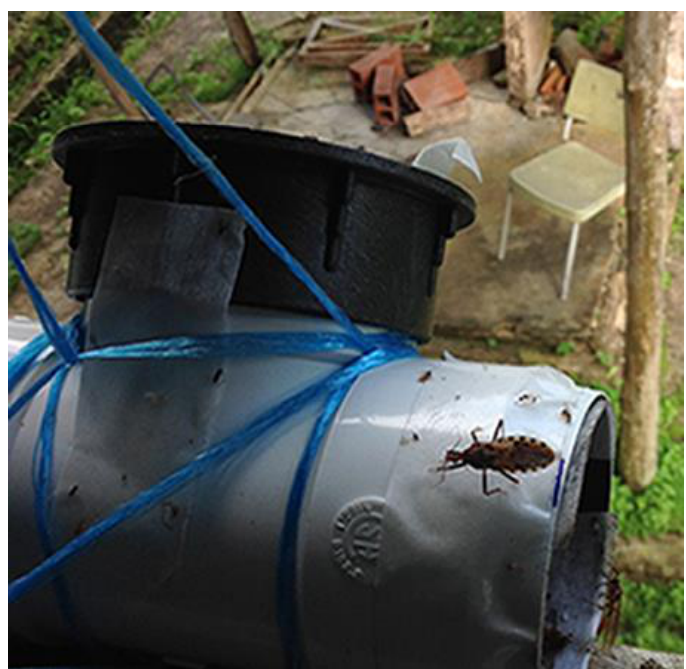
Figure 2. Successful mouse-baited trap. Adult P. geniculatus is caught on the adhesive material lining the outside of the trap. The trap is set on a windowsill, near an artificial light on the exterior of a ranger station in the village of Mt. Harris. Photo by J. K. Peterson.